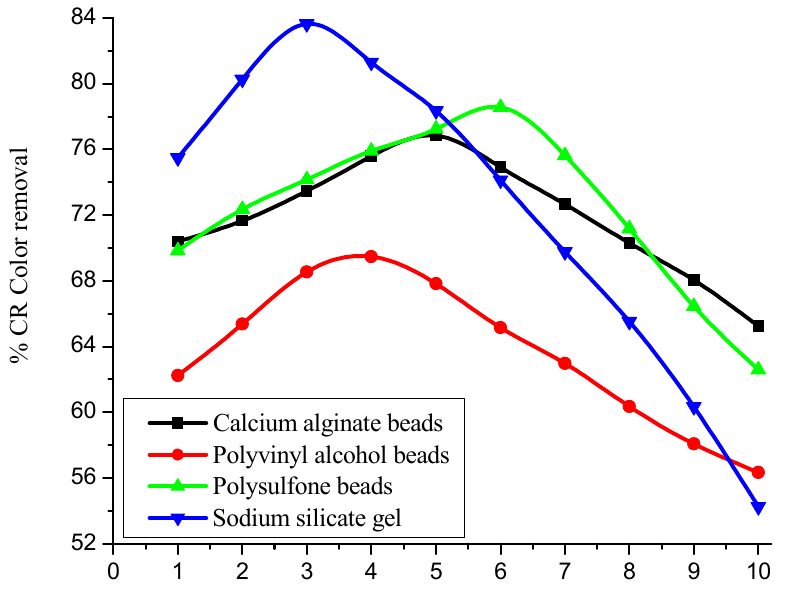
Figure 2. Effect of Nelumbo nucifera leaf powder (NNLP) adsorbent loading in various polymeric matrices on CR dye decolorization. (Initial pH: 6; initial dye concentration: 250 mg L − 1 ; free NNLP adsorbent particle size: 94 µ m; immobilized adsorbent dosage: 6 g L − 1 ; agitation speed: 150 rpm; temperature: 301 K; contact time: 24 h) Table 2. Physical properties of various polymeric matrices immobilized with NNLP adsorbent. NNLP Various Polymeric Matrices